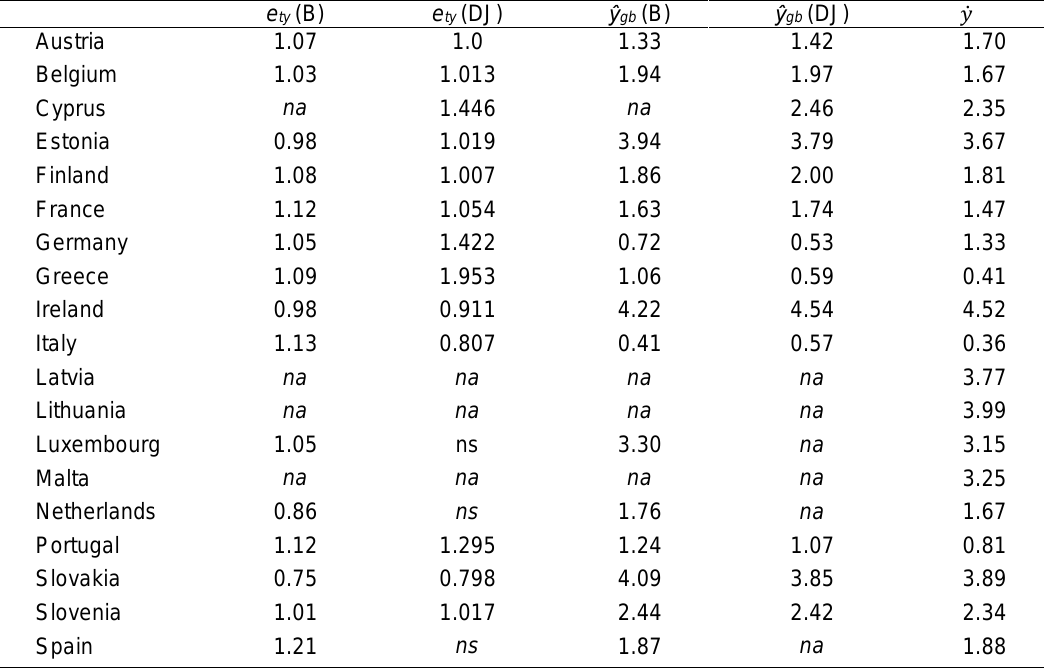
Table 2. Robustness